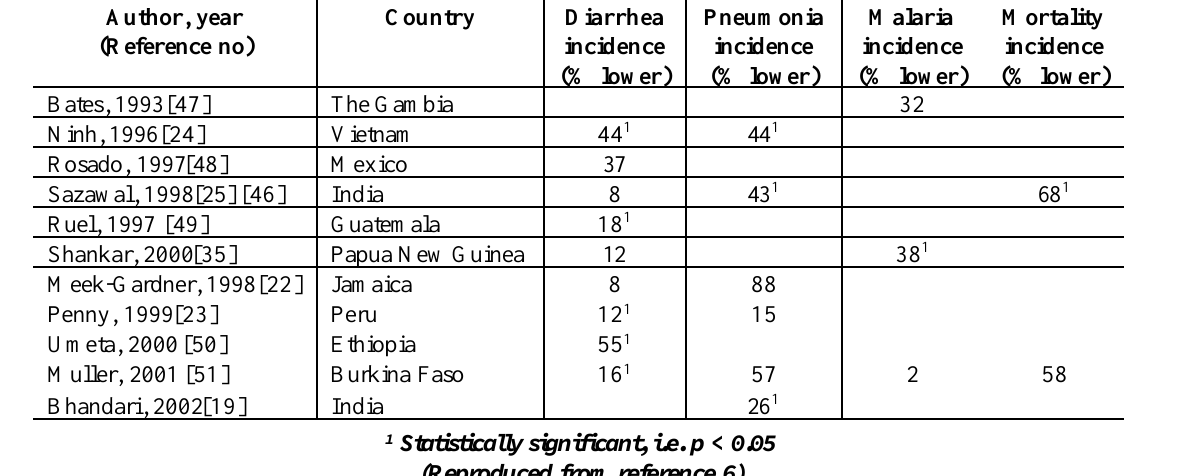
1 Statistically significant, i.e. p < 0.05